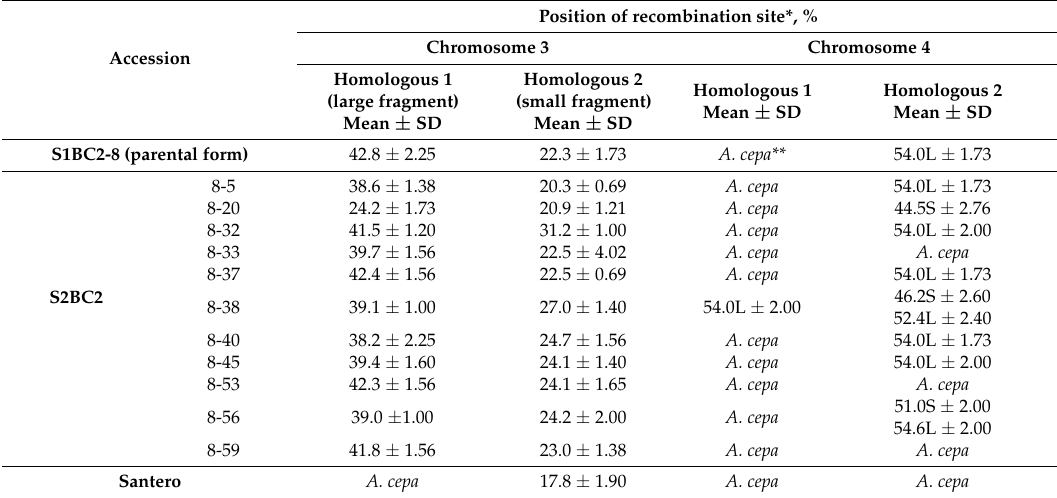
Table 1. The position of recombination sites between A. cepa and A. roylei within recombinant chromosome 3 and 4 in S 1 BC 2 and S 2 BC 2